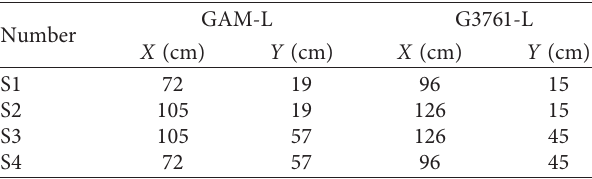
Table 7: The coordinates of sensors on the plate-shaped rock in Scheme